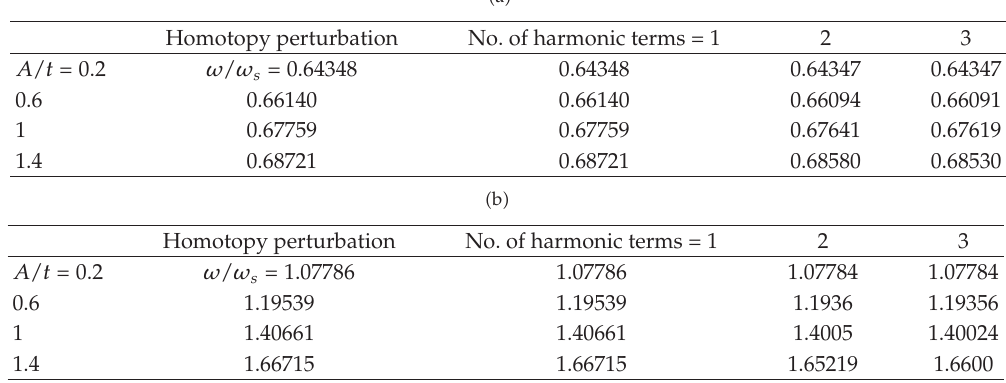
Table 2: (cid:3) a (cid:6) Acoustic mode convergence for various amplitudes (cid:3) 1st resonant frequency (cid:6) . (cid:3) b (cid:6) Acoustic mode convergence for various amplitudes (cid:3) 2nd resonant frequency (cid:6)